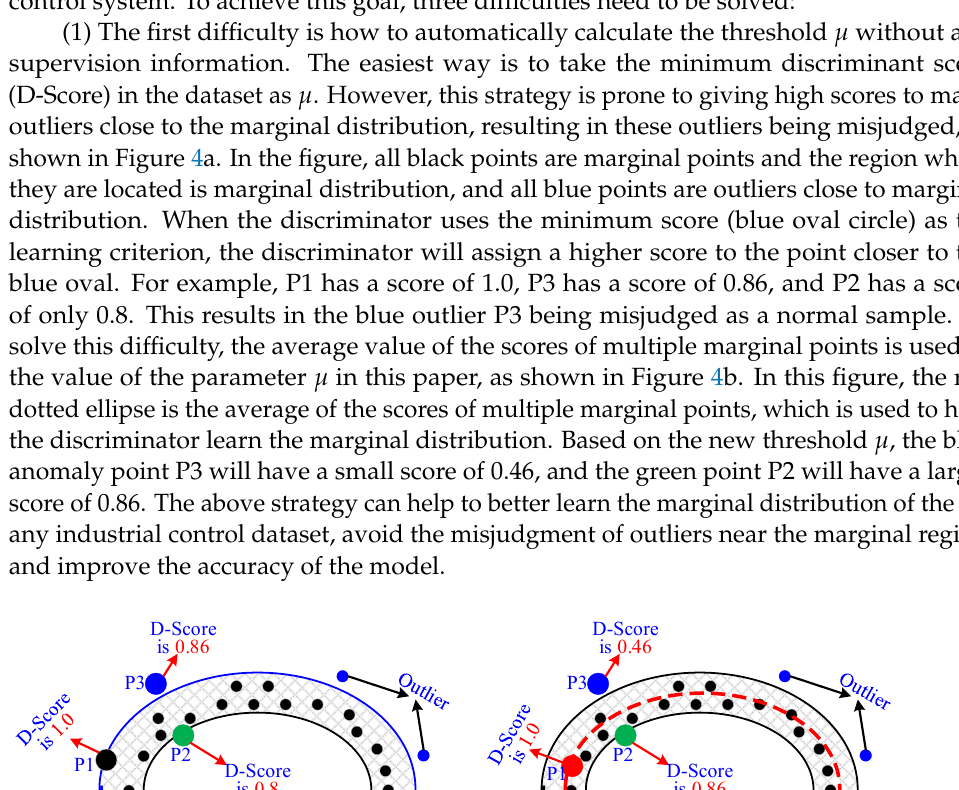
Figure 3. Correlation of discriminator score with marginal distribution.